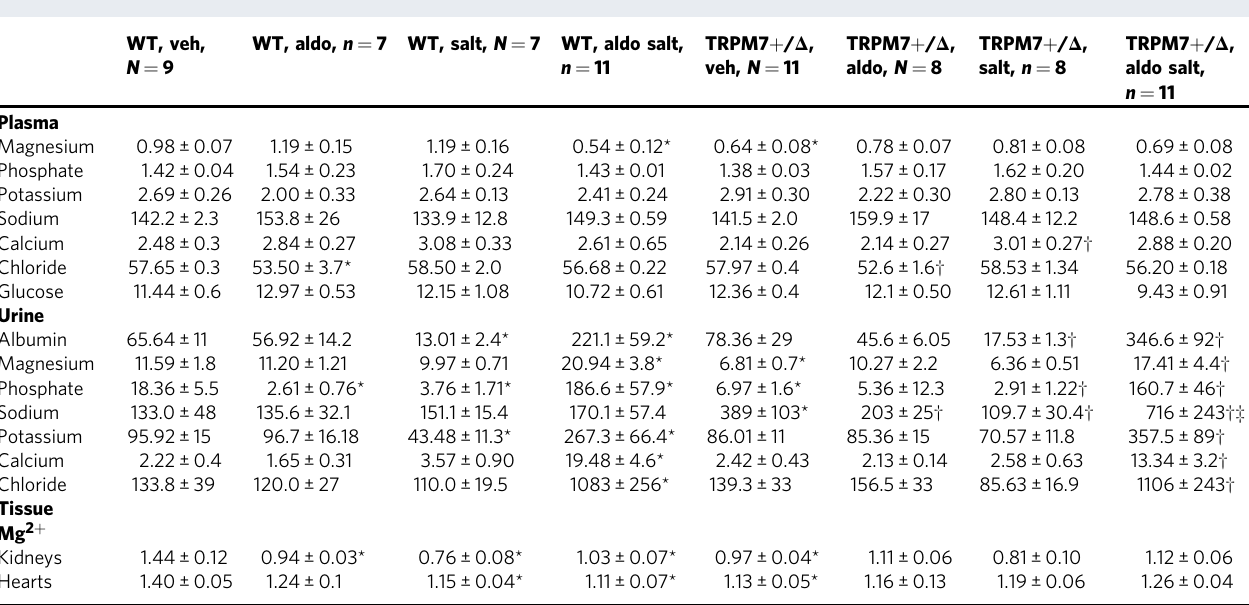
Table 2 Plasma and Urine analysis and tissue Mg 2 + from WT and TRPM7 + / Δ kinase mice. WT, veh, N =